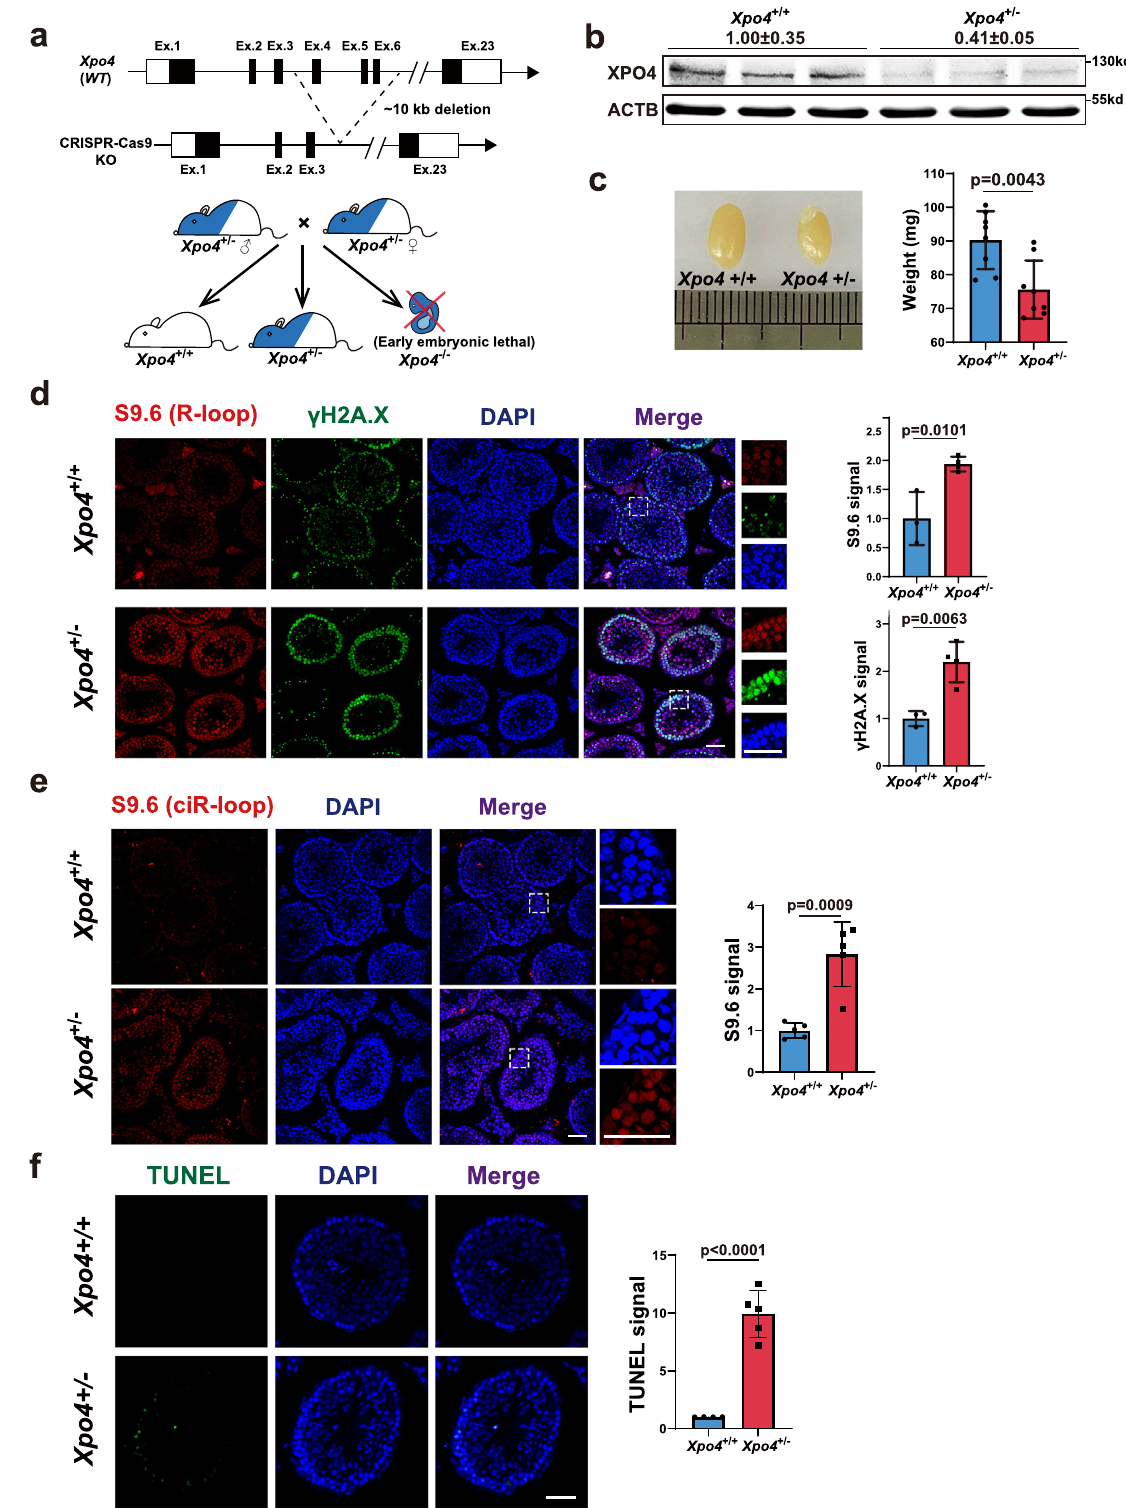
Fig.5|Insuf fi cientXPO4dosagecausestestisde fi citsin Xpo4 +/ − mice.a Scheme for generation of CRISPR-cas9 Xpo4 knockout (KO) mouse. Xpo4 − / − homo- zygotes were early embryonic lethal. b XPO4 protein levels of Xpo4 +/+ and Xpo4 +/ − mice. c Representative images of testes of Xpo4 +/+ and Xpo4 +/ − mice. Quanti fi cation of testis weight is shown. n = 8 ( Xpo4 +/+ ) and 8 ( Xpo4 +/ − ). d Representative IF images with enlarged regions of R-loop and γ H2A.X (DNA damage) in testes of Xpo4 +/+ and Xpo4 +/ − mice (DAPI, blue; R-loop, red; DNA damage, green). Representative images and quanti fi cation are shown. n =3